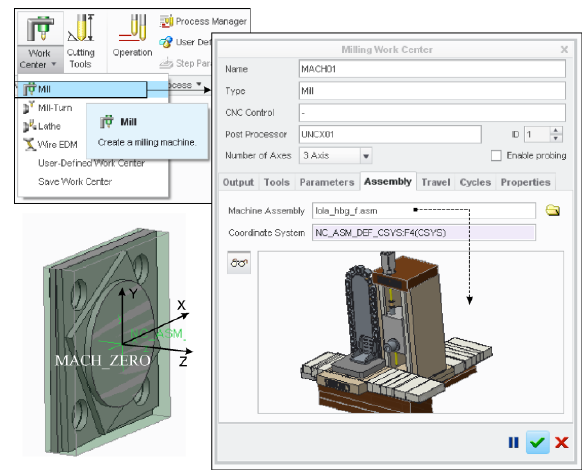
Figure 5. Selection and loading of the virtual machine with the coordinate system of the